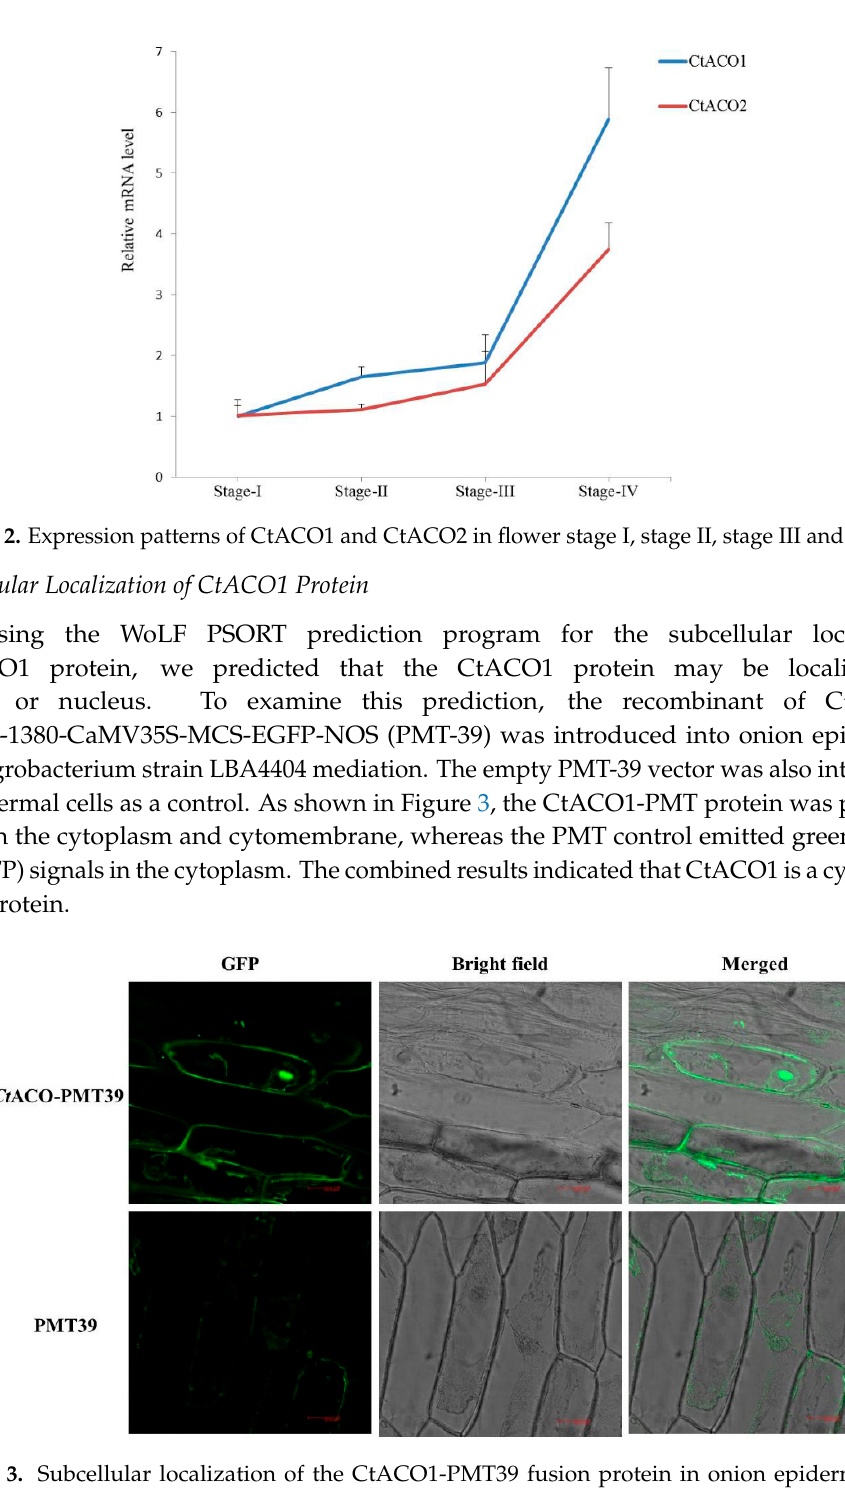
Figure 3. Subcellular localization of the CtACO1-PMT39 fusion protein in onion epidermal cells. The fluorescence emission signals were determined by a confocal laser scanning microscope. GFP fluorescence (GFP; green fluorescent protein), optical photomicrographs (bright field), and an overlay of bright and GFP fluorescence illumination (merged) are shown.